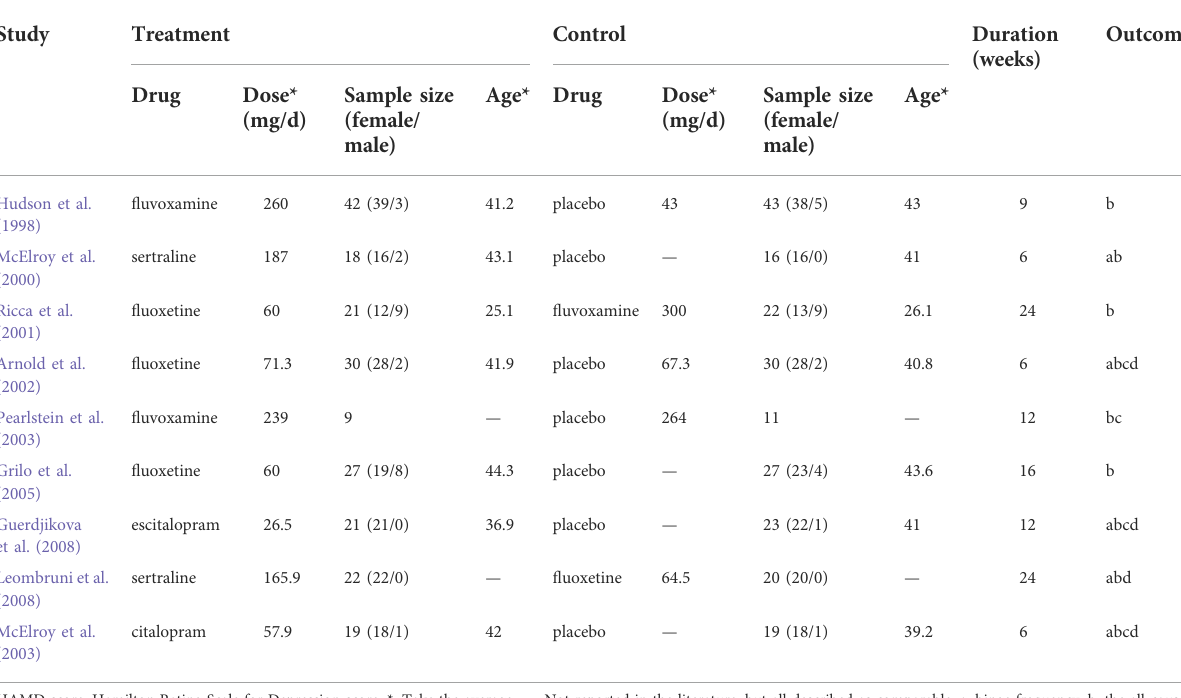
TABLE 1 Characteristics of included studies.